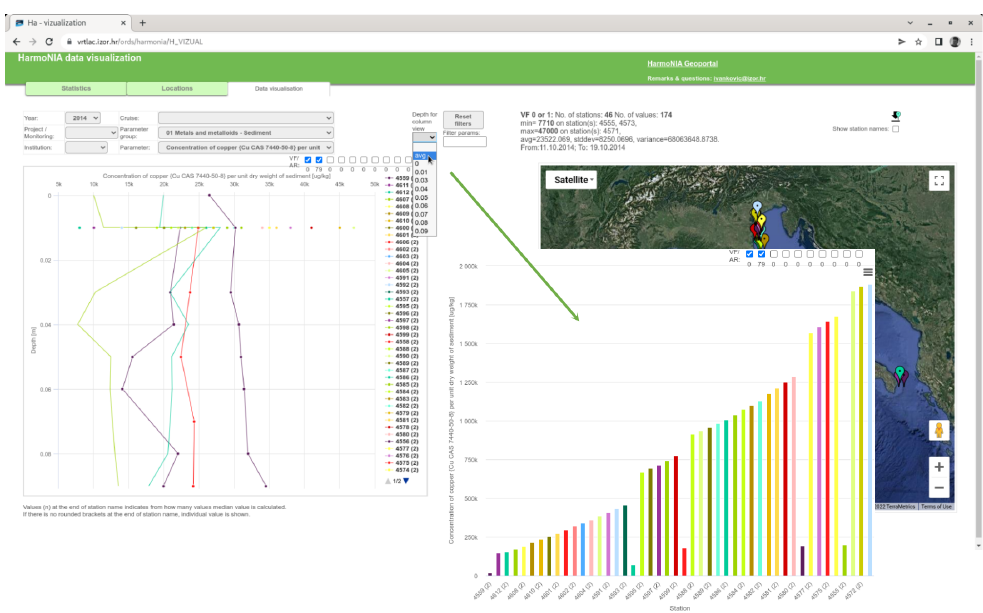
Figure 10. Usage of “many to one depth” tool from web application.